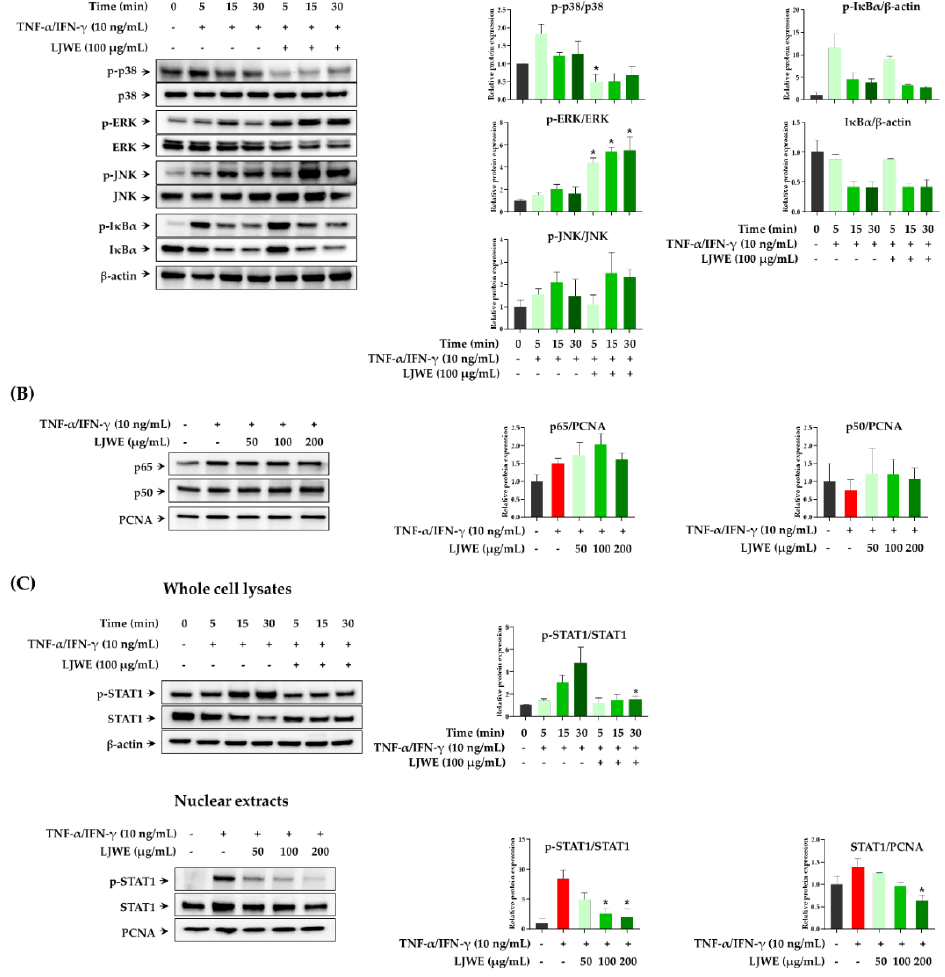
Figure 2. Modulatory effects of LJWE on mitogen-activated protein kinases (MAPKs), nuclear factor-kappa B (NF-κB), and signal transducer and activator of transcription 1 (STAT1) signaling pathways in tumor necrosis factor (TNF)-α/interferon (IFN)-γ-stimulated HaCaT cells. The cells were pretreated with (+) or without (−) LJWE for 1 h and incubated in the presence (+) or absence (−) of TNF-α/IFN-γ (each 10 ng/mL) for 5, 15, and 30 min. Western blotting was performed to determine the phosphorylation and degradation of p38, extracellular signal-regulated kinase (ERK) and c-Jun N-terminal kinase (JNK), Inhibitor kappa B-alpha (IκBα), and STAT1 in whole cell lysates. The translocation of NF-κB and STAT1 was determined 3 h post-TNF-α/IFN-γ treatment. ( A ) Effects of LJWE on the phosphorylation and degradation of MAPKs in whole cell lysates. ( B ) Effects of LJWE on the nuclear translocation of NF-κB. ( C ) Effects of LJWE on the activation (upper panel) and nuclear translocation (lower panel) of STAT1. * p < 0.05 vs. control treated with vehicle. PCNA, proliferating cell nuclear antigen.